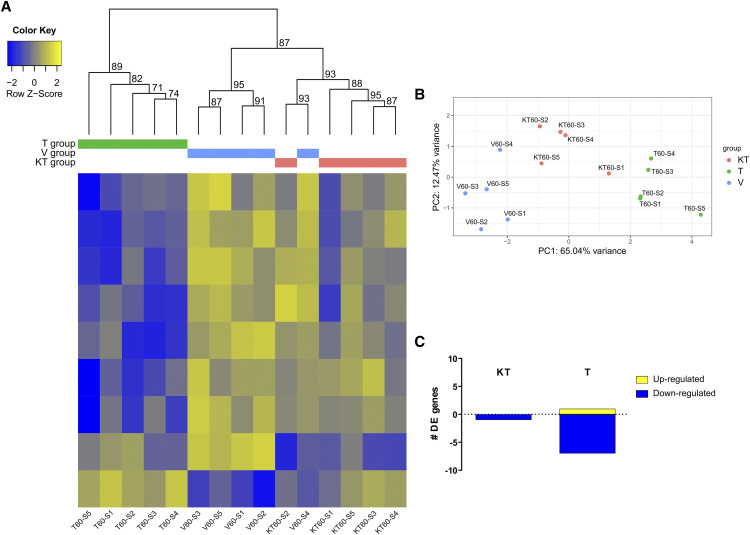
Differences in brain expression patterns of fish injected with vehicle (V-treated group), 11-ketotestosterone (KT-treated group) or testosterone (T-treated group); sampling time point of 60 min. A. Heatmap of differentially expressed genes. Intensity of color indicates relative expression levels of each gene (rows) in each treatment sample (columns), with blue representing downregulated transcripts and yellow upregulated transcripts. For each cluster obtained with hierarchical clustering, unbiased p-values (value between 0 and 1 but here in %) can be seen above the heatmap. These values were calculated via multiscale bootstrap resampling, indicating how strong the cluster is supported by data. B. Principle Component Analysis (PCA) of DE genes of fish from the three treatment groups. C. Number of differentially expressed genes of fish injected with 11-ketotestosterone (KT-treated group) or testosterone (T-treated group) using a vehicle group (V-treated group) as a reference group.